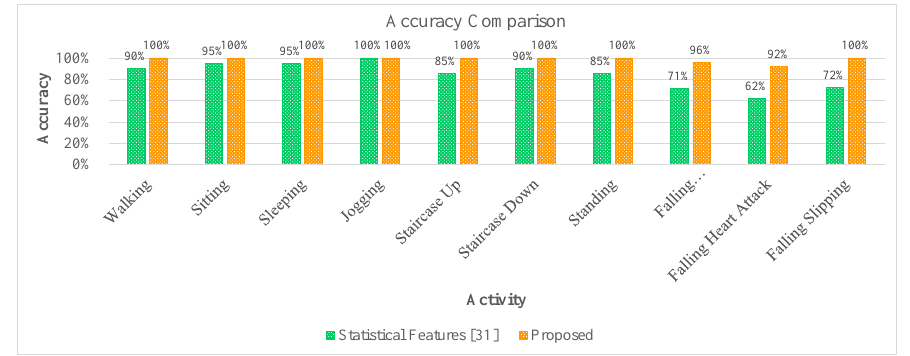
Figure 12. Class-wise accuracy comparison of the proposed model with other state-of-the-art models on the DU-MD dataset. Table 2. Feature based performance (%) of the proposed model on both datasets. No. of